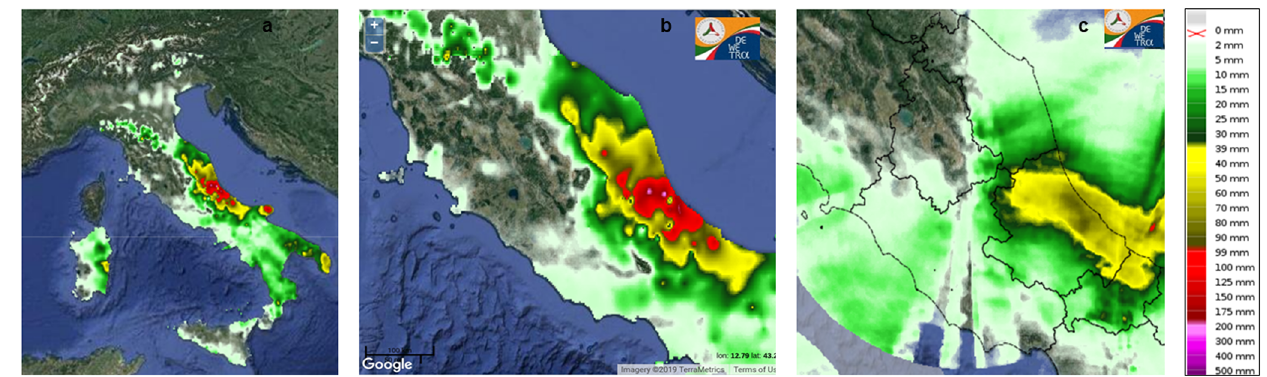
Figure 2. Observed accumulated precipitation over 24h starting on 14 November 2017 at 12:00UTC: (a) over Italy and (b) over Central Italy and for (c) radar surface rainfall total (SRT). The daily rainfall maps and the radar data are provided by the DEWETRA platform (Italian Civil Protection